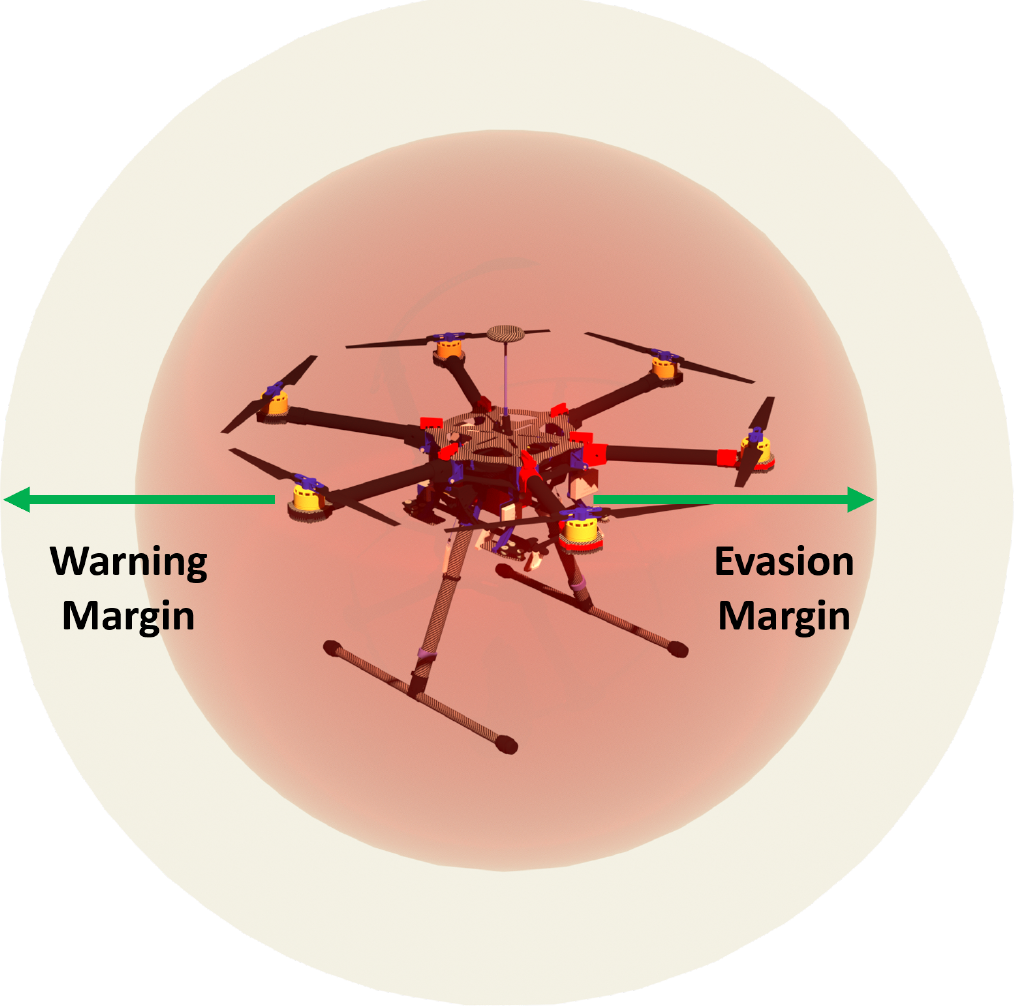
Figure 13. Collision avoidance system based on